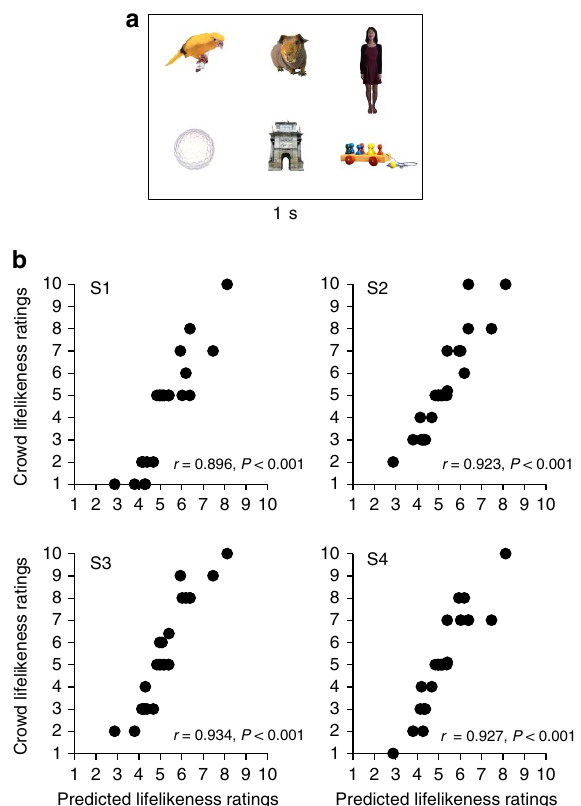
Figure 2 | Experiment 2 stimuli and results. ( a ) In the whole set condition, a display of six stimuli was presented for 1s. Participants then rated the average lifelikeness of the group of stimuli using a slider bar. ( b ) Experiment 2 results for four representative subjects. The observers’ ratings (black circles) of crowd lifelikeness ( y axis) were well predicted by the average of individual item ratings derived from an independent group of observers in Experiment 1 ( x axis), using a Pearson correlation, n ¼